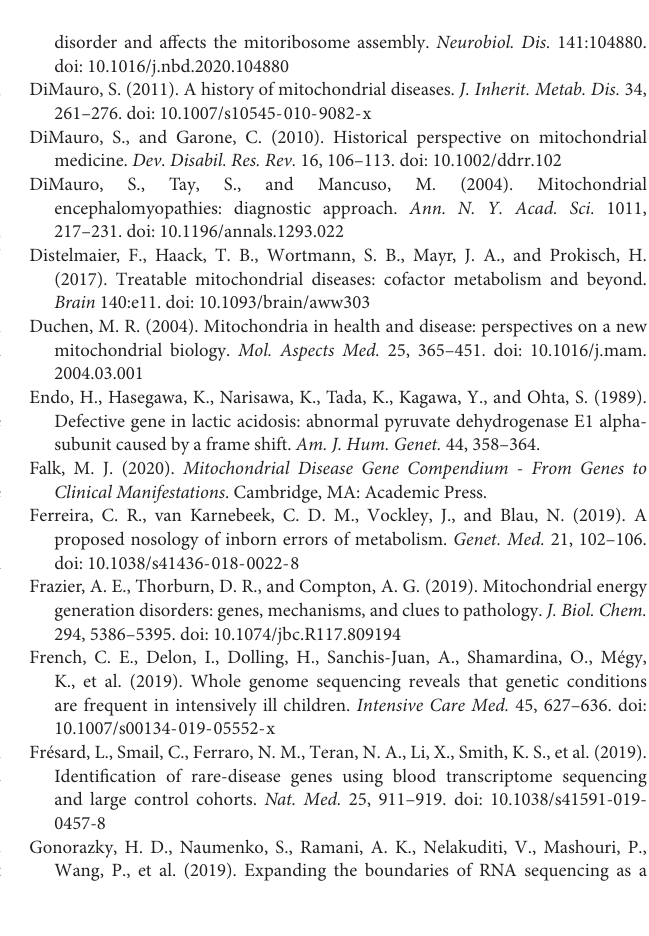
Supplementary Table 2 | Current list of published mitochondrial disease